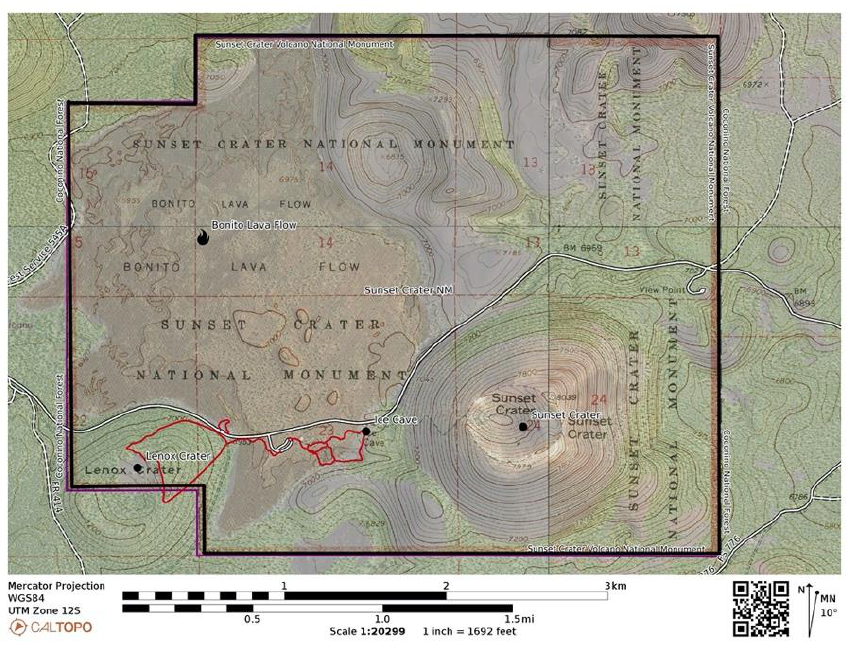
Figure 9. Map of Sunset Crater.